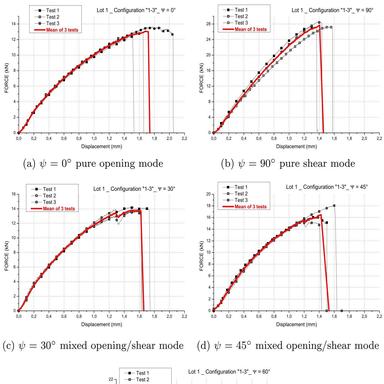
Force vs. displacement responses for pure opening mode (a) ψ = 0∘ , pure shear mode (b) ψ = 90∘ and mixed opening/shear mode (c) ψ = 30∘ , (d) ψ = 45∘ , (e) ψ = 60∘ .